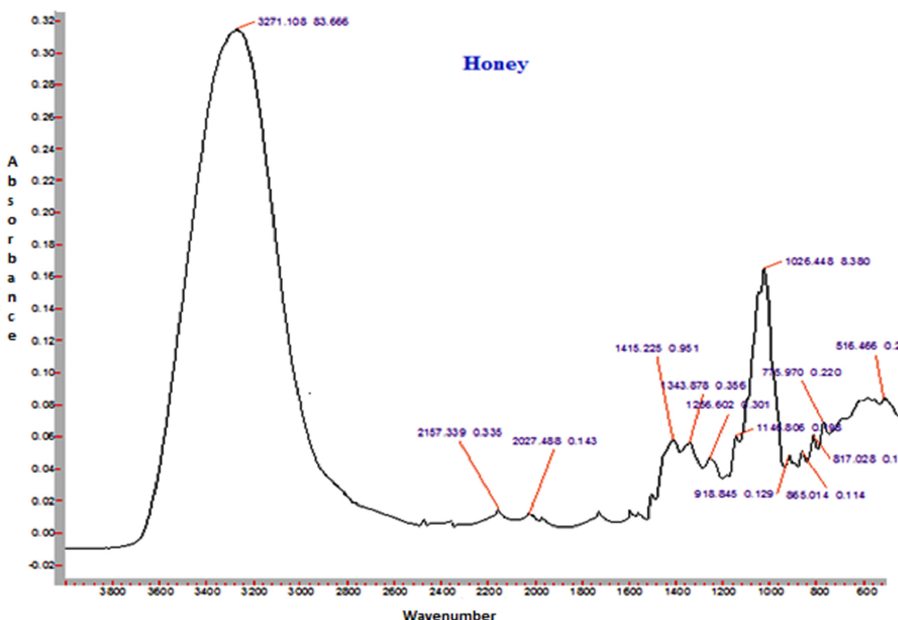
Figure 3. Representative FTIR spectrum of sunflower honey. Figure 3